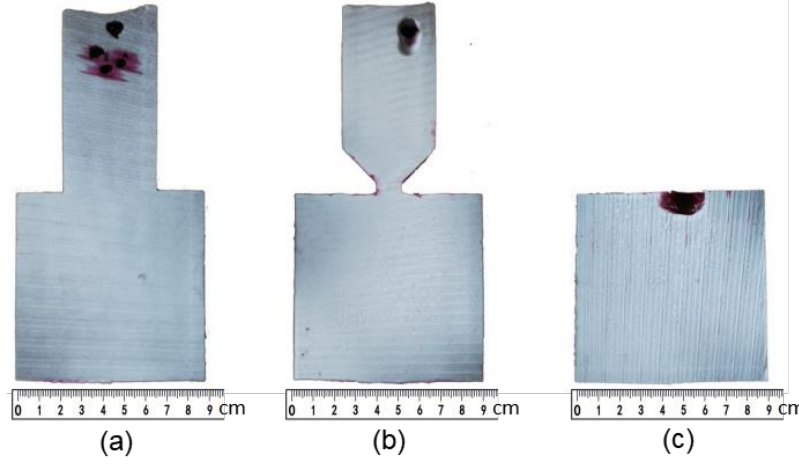
Figure 7. Cross-section topography of the prototypes poured at 1350 °C: ( a ) Prototype A1, macro porosity hole at the top of the riser; ( b ) Prototype B1, macro porosity hole at the top of the riser; ( c ) Prototype C1, macro porosity hole at the top of the casting.